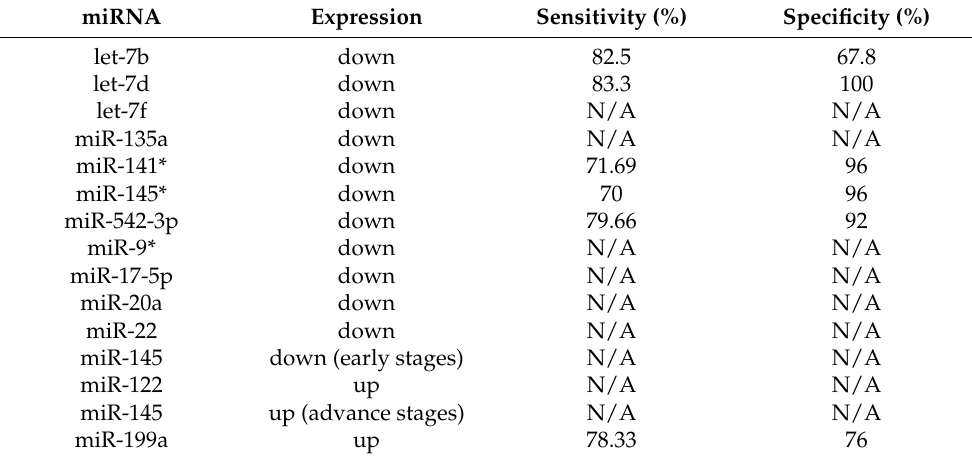
Table 2. miRNAs differentially expressed in serum samples of patients with